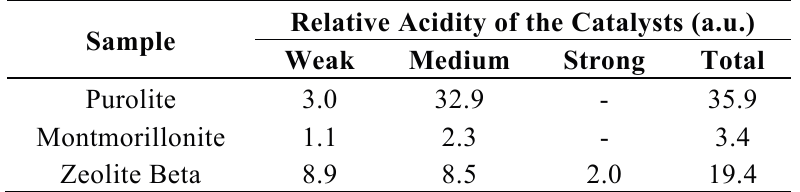
Table 4. Relative population and distribution of acid centres in the most active catalysts, obtained from temperature-programmed desorption (TPD) of